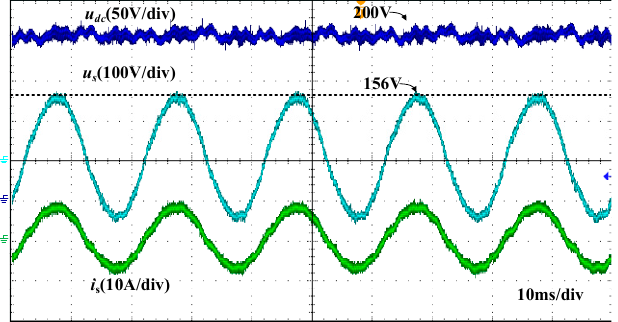
Figure 12. Experiment waveforms of input voltage u s , input current i s , and output voltage u dc in the proposed method.